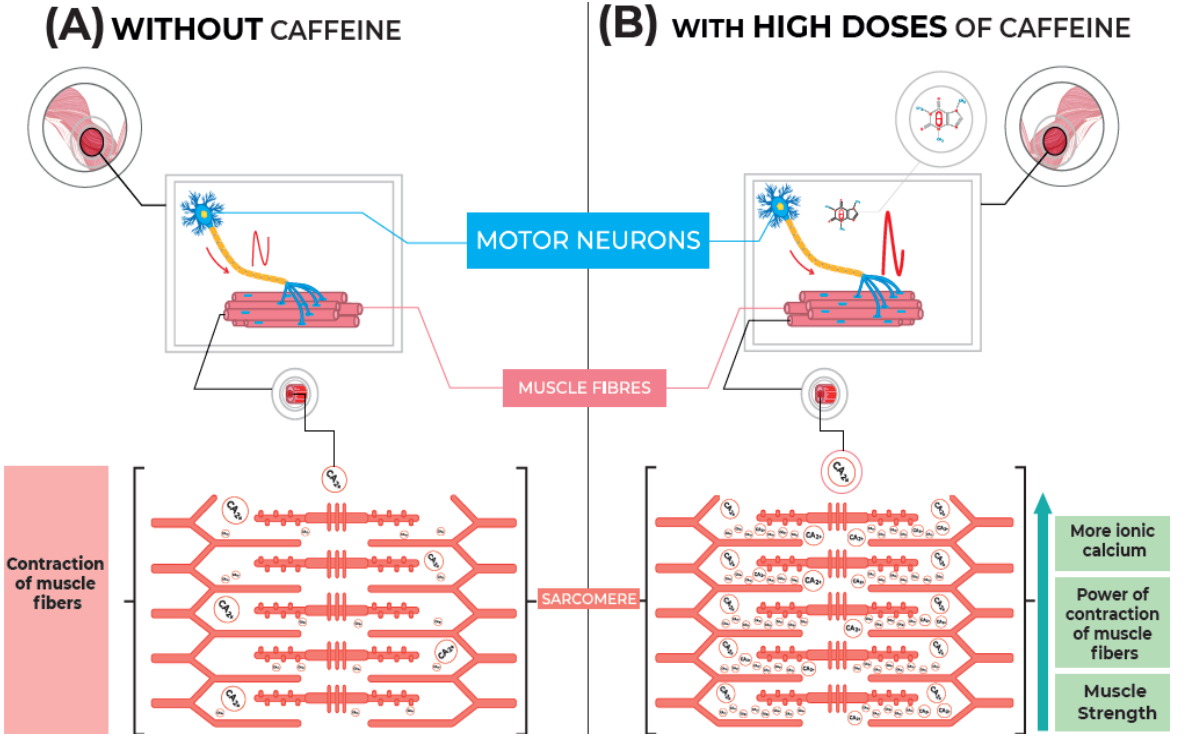
Figure 5. Possible mechanism of action of caffeine in increasing muscle strength at high doses. Figure 5. ( A ) Representation of the neuromuscular stimulus on the release of ionic calcium in muscle fibers and its impact on the increase in the power of contraction triggered by actin and myosin filaments in a “basal” condition (or on the placebo condition); ( B ) Representation of the more pronounced neuromuscular stimulus after the administration of high doses of caffeine, providing a more pronounced increase in the release of calcium ions and, probably, increasing the power of contraction of muscle fibers and muscle strength.